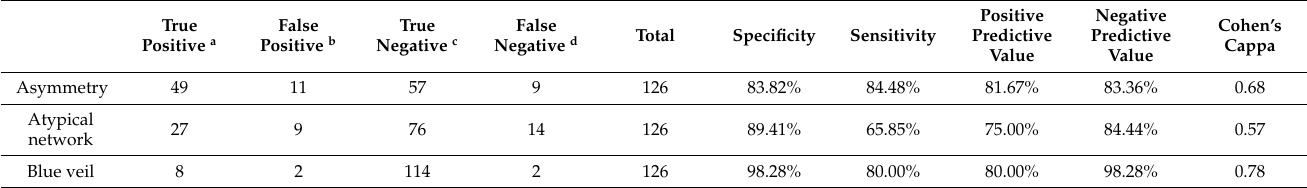
Table 2. Results of the dermoscopic assessment by the expert and the